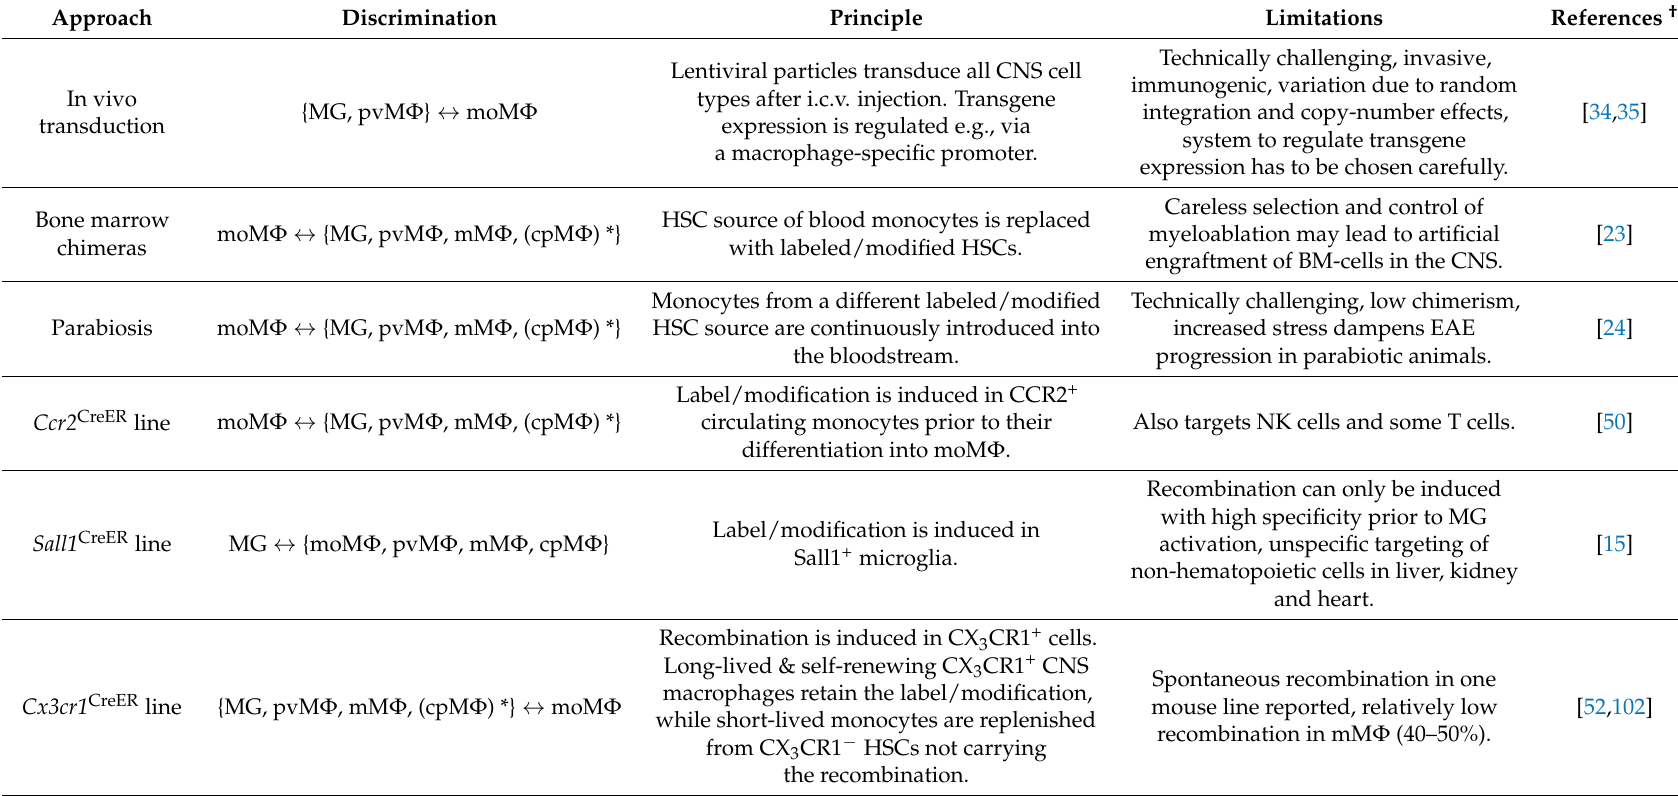
Table 2. Methods to distinguish and genetically modify infiltrating and resident CNS